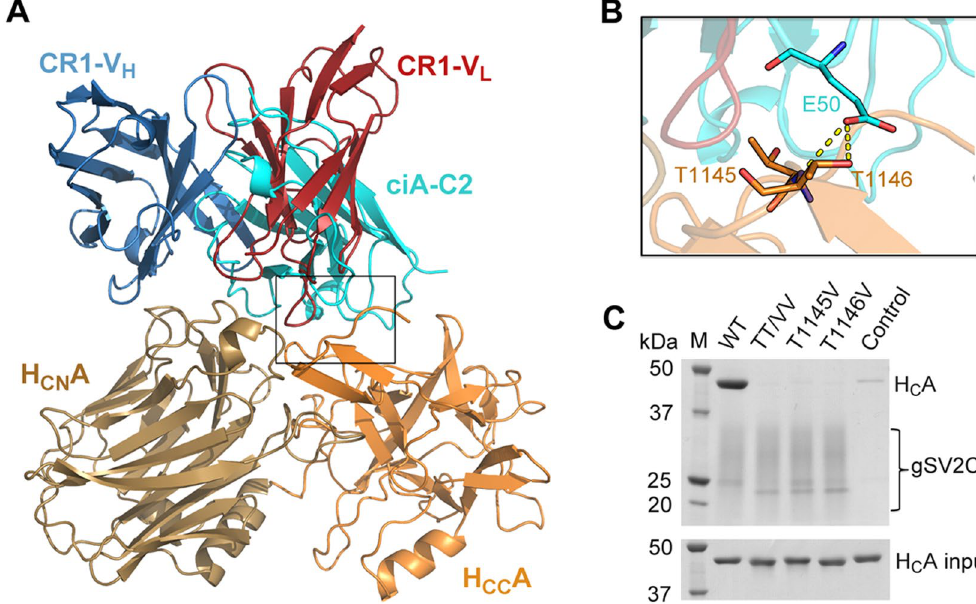
Figure 5. ciA-C2 binds to both subdomains of H C A1 while CR1 primarily binds to H CN A1. ( A ) Superposition of the structures of the H C A1-ciA-C2 and H C A1-CR1 (PDB: 2NYY) complexes. ( B ) A close-up view of the interface around the H CC A1 subdomain highlighted in a box in panel A. ciA-C2 (cyan) occupies a crucial SV2- binding area on H CC A1 (orange) involving residues T1145 and T1146, but CR1 (red) does not. ( C ) Pull-down assays using gSV2C as bait and H C A1 (WT and mutants) as preys. TT/VV: H C A1-T1145V-T1146V. Ni-NTA resins incubated with H C A1-WT in the absence of gSV2C were used as a negative